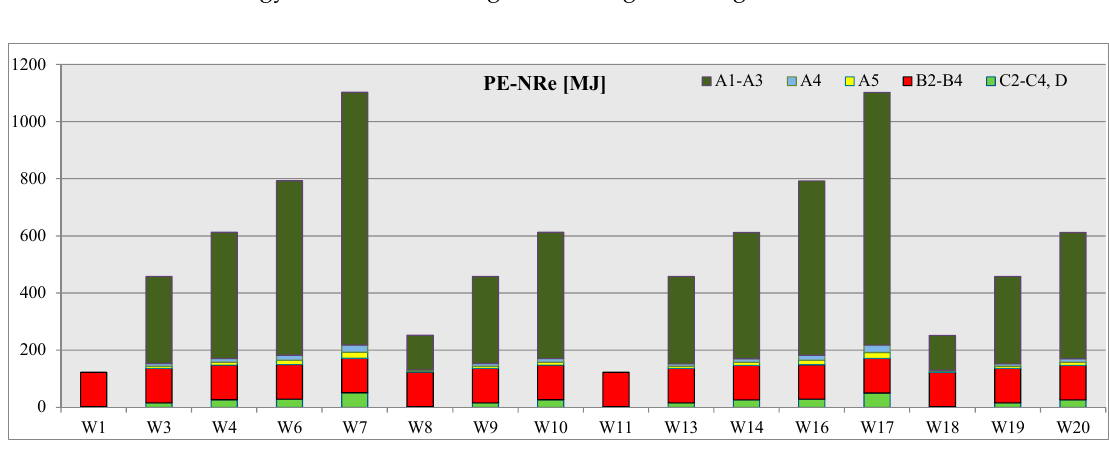
Figure 3. C2C Global Warming Potential (GWP, in kg CO 2 eq, with the energy needed for heating and cooling not being considered) of each alternative of external wall.